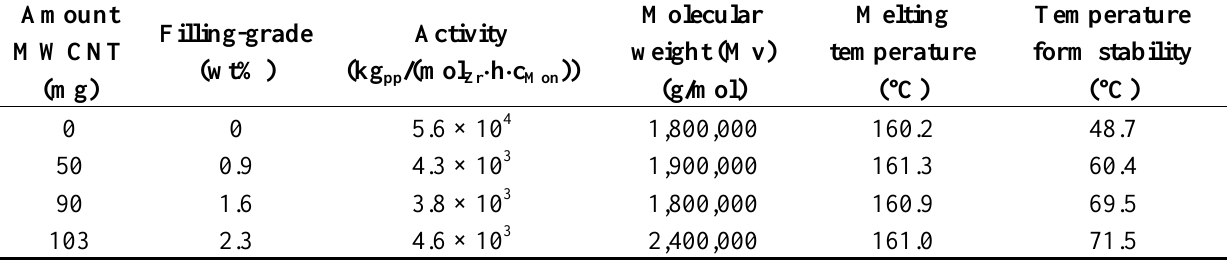
Table 7 summerizes the polymerization activities and some polymer properties of isotactic. Table 7. Polymerization activities, viscosity average molecular weights, melting temperatures, and form stability temperatures of iPP/MWCNT samples with different amounts of fillers at a force of 1.8